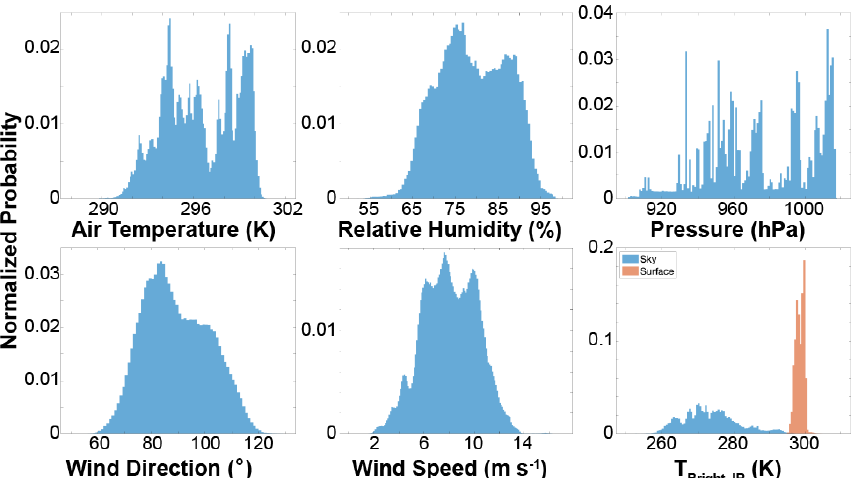
Figure 6. Histograms of the primary measurements from RAAVEN, collected while in flight, over all flights conducted during